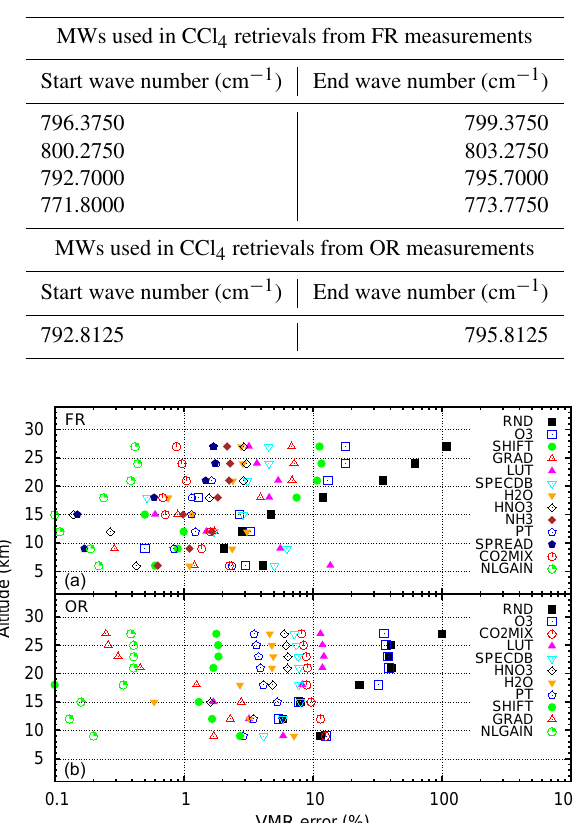
Table 1. Microwindows (MWs) used for CCl 4 retrieval from nomi- nal FR and OR MIPAS measurements.